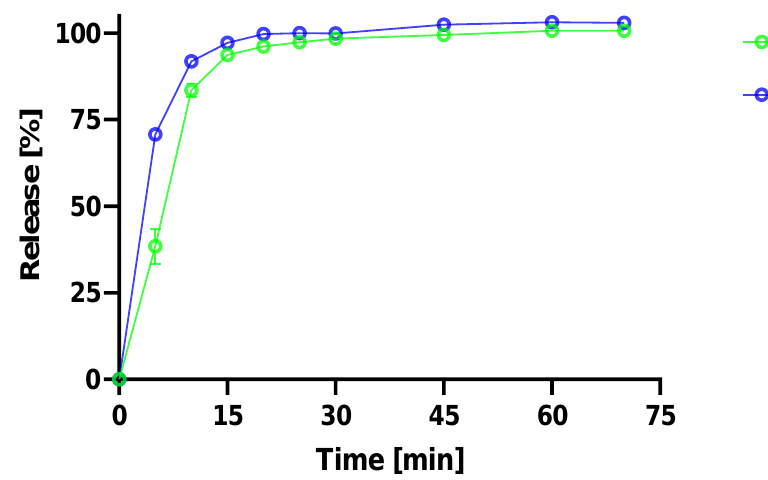
Figure 2. Time–concentration profiles of Panadol and Panadol Rapid when analyzed by the USP II dissolution test (n = 3).